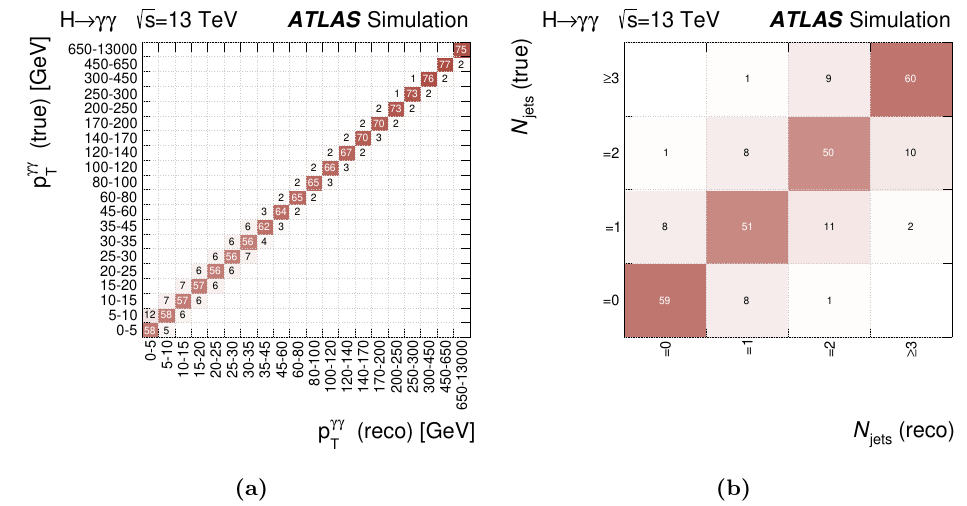
Figure 3. Response matrices (in %) evaluated from MC simulations of Higgs bosons decaying into two photons for (a) the transverse momentum of the diphoton system p γγ jets N . Each matrix element is the probability for a signal event generated in a fiducial truth-bin jets to be selected in a reconstructed reco-bin. Values smaller than 1% (after rounding) are not shown.